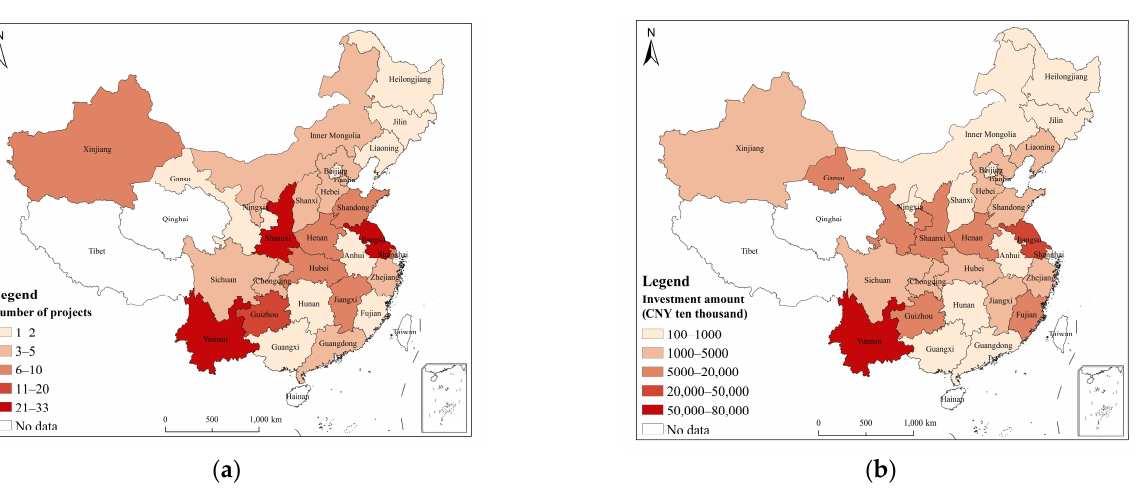
Figure 3. The implementation of WSMC projects between 2016 and 2020 by province, where ( a ) is the number of WSMC projects; ( b ) is the investment amount of WSMC projects.